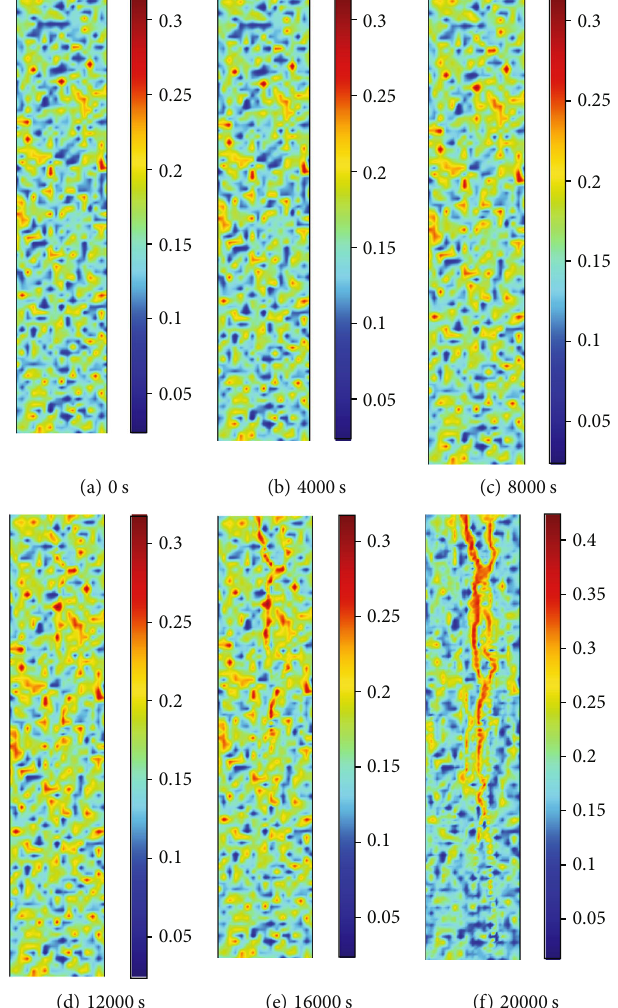
Figure 10: Porosity cloud map